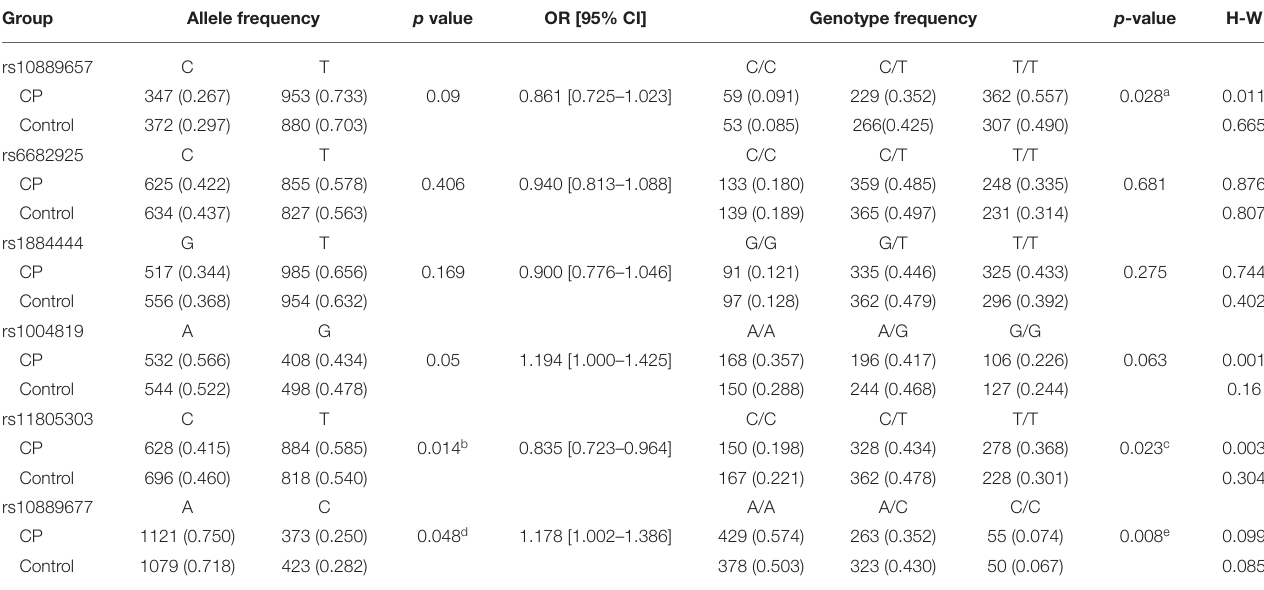
TABLE 2 | Allele and genotype frequency analysis of SNPs of IL-23R . Group Allele frequency p value OR [95% CI] Genotype frequency p- value H-W